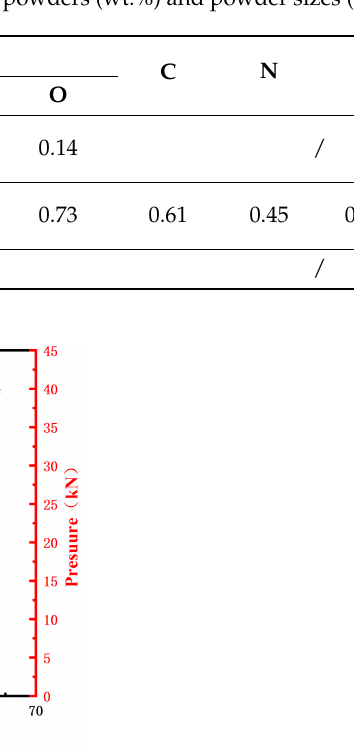
Figure 1. Schematic diagram of the preparation process. Table 1. Chemical compositions of the alloyed powders (wt.%) and powder sizes ( μ m).